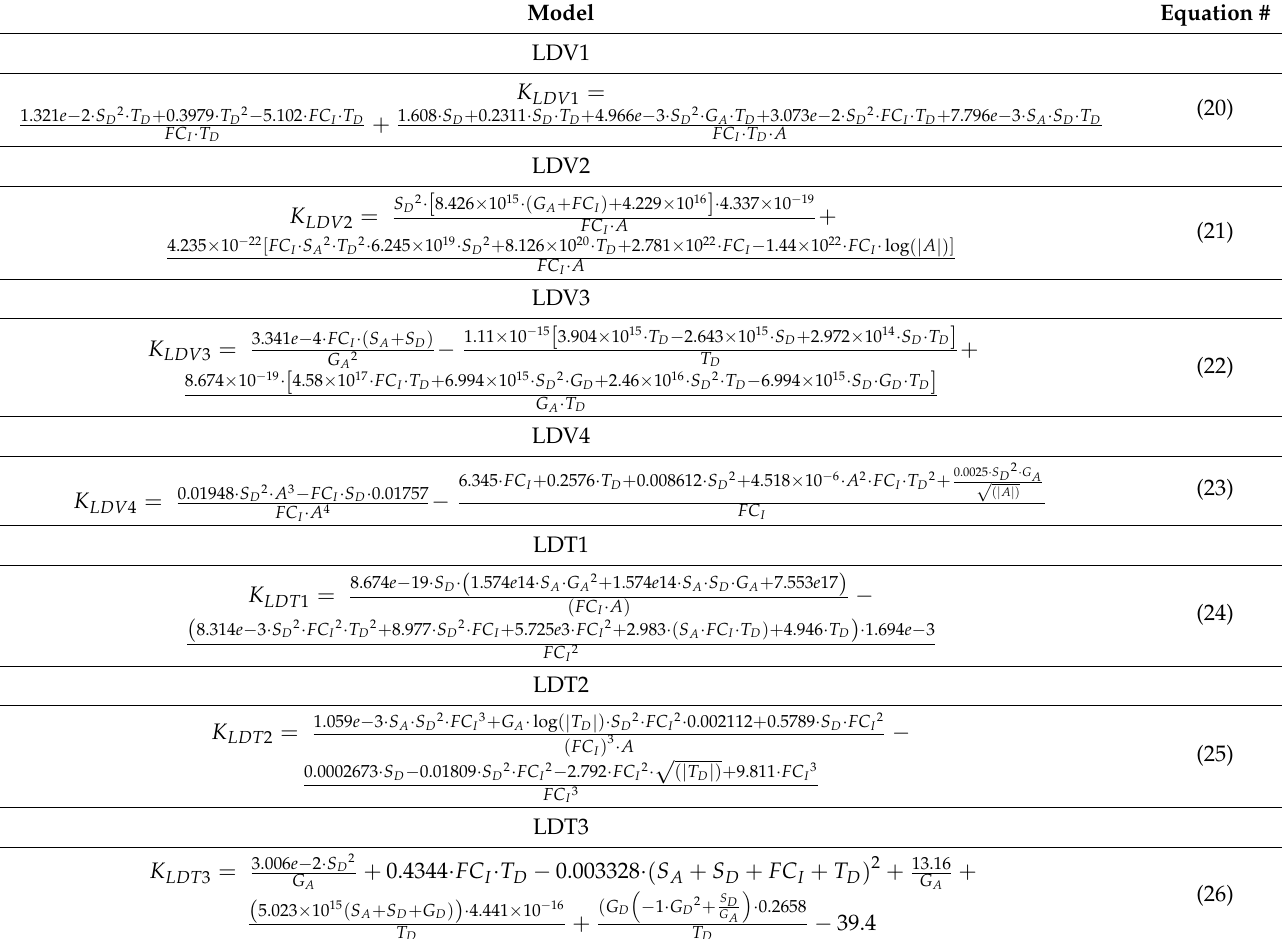
Table 4. Mathematical formulations of the MGGP